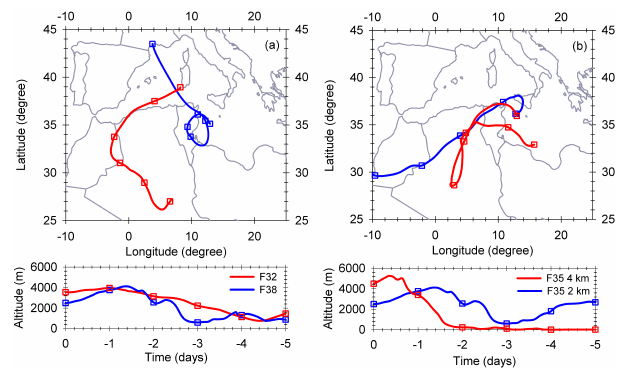
Figure 6. Five-day backward trajectories calculated for (a) flights F32 and F38 and (b) flight F35 arriving at 2 and 4kma.s.l. altitudes in blue and red